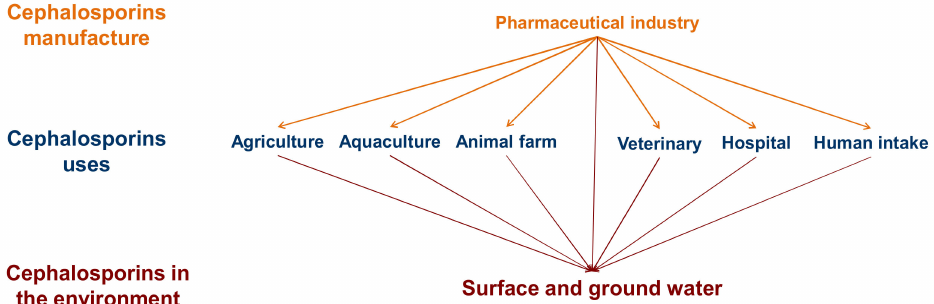
Figure 1. Sources of the presence of cephalosporins in the environment.